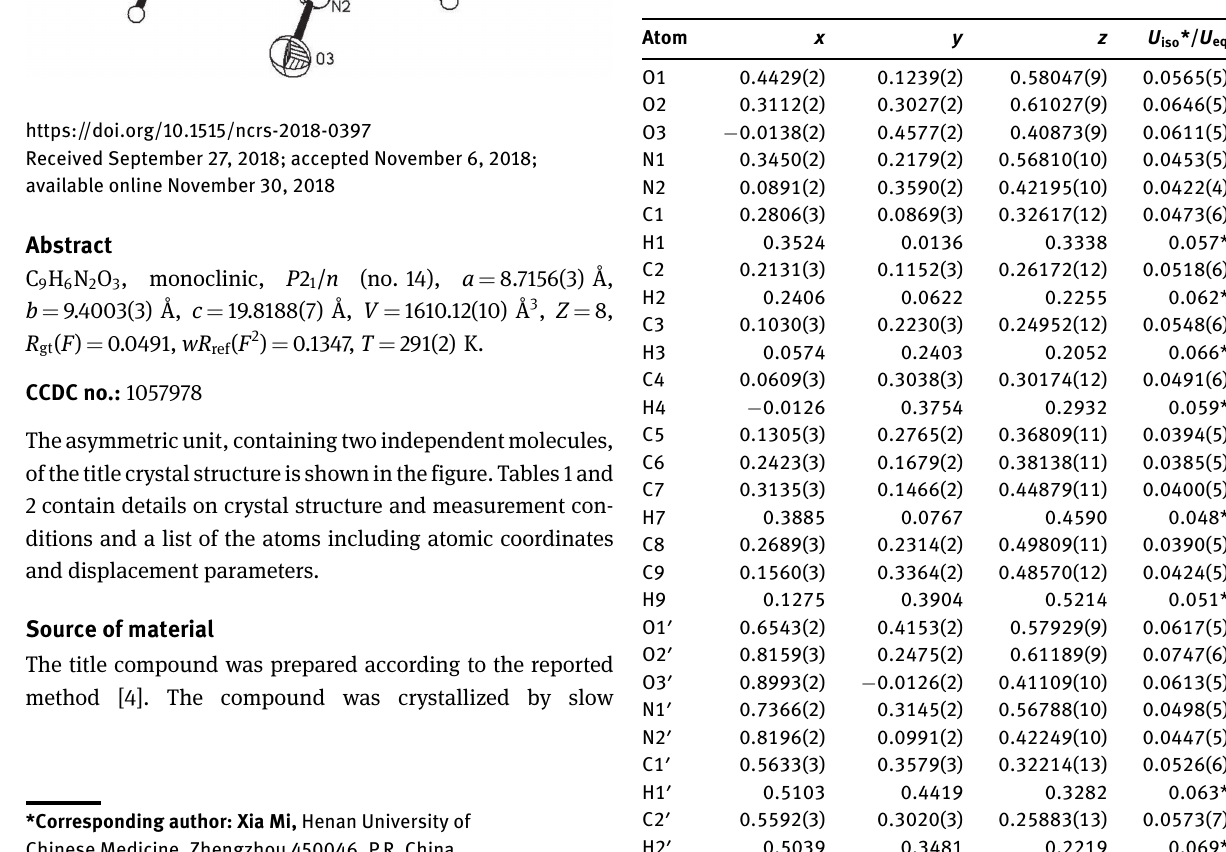
Table 2: Fractional atomic coordinates and isotropic or equivalent isotropic displacement parameters (Å 2